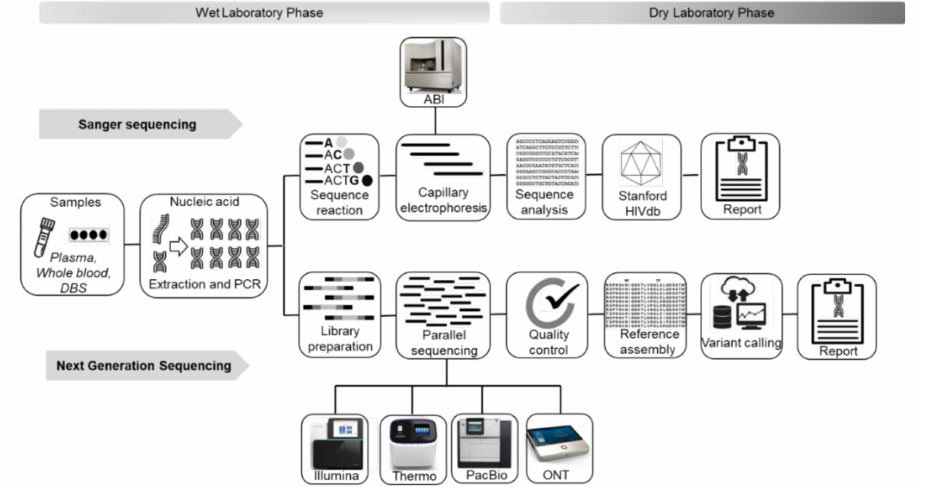
Figure 1. Summary comparison of Sanger sequencing and NGS HIVDR workflows.ABI, Applied Biosystems; DBS, dried blood spots; HIV db, HIV drug resistance database; ONT, Oxford Nanopore Technology; PacBio, Pacific Biosciences; PCR, polymerase chain reaction; Thermo, Thermo